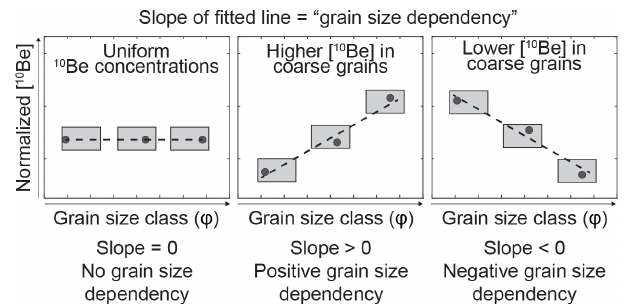
Figure 4. Schematic showing the concept of measuring grain size dependency. A random point was selected within each grain size range and from the corresponding 10 Be concentrations ( ± analyti- cal error) (boxes). The slope of a line fitted to the randomly selected points represents the grain size dependency. We used a Monte Carlo simulation of 1000 runs to account for the width of the grain size range and the analytical errors in 10 Be concentrations. This yields a mean grain size dependency with error bars.